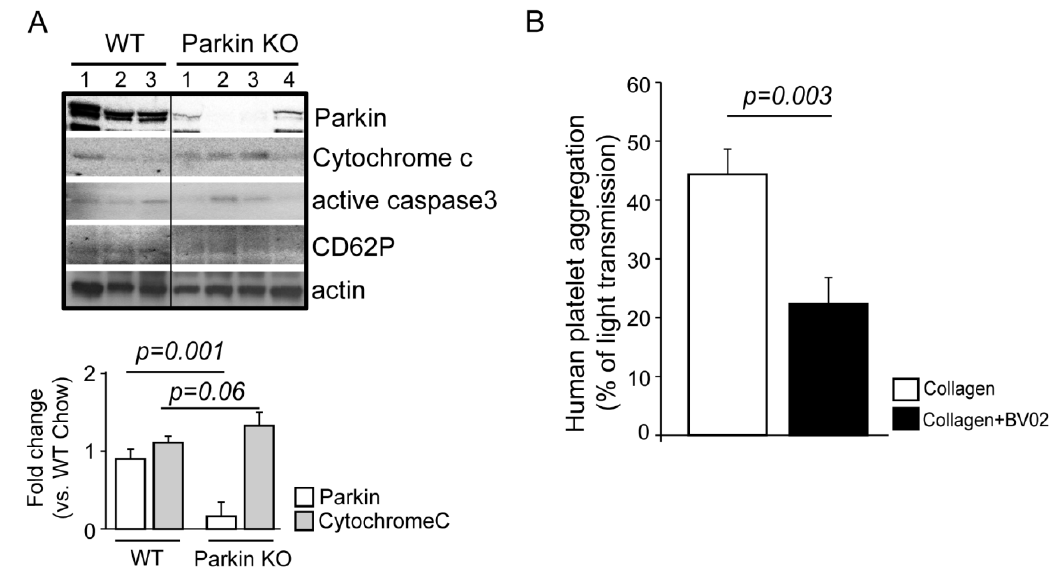
Figure 5. Parkin associated with apoptosis and platelet aggregation. ( A ) Western blot analysis of Parkin KO mice platelets. Parkin, Cytochrome C, active caspase3, and CD62P antibodies were used for this experiment. The numbers indicate individual mice. ( B ) Quantification of each group using ImageJ software. ( B ) Collagen induced platelet aggregation in human platelets ( n = 3) after BVO2 (14-3-3 inhibitor) treatment.